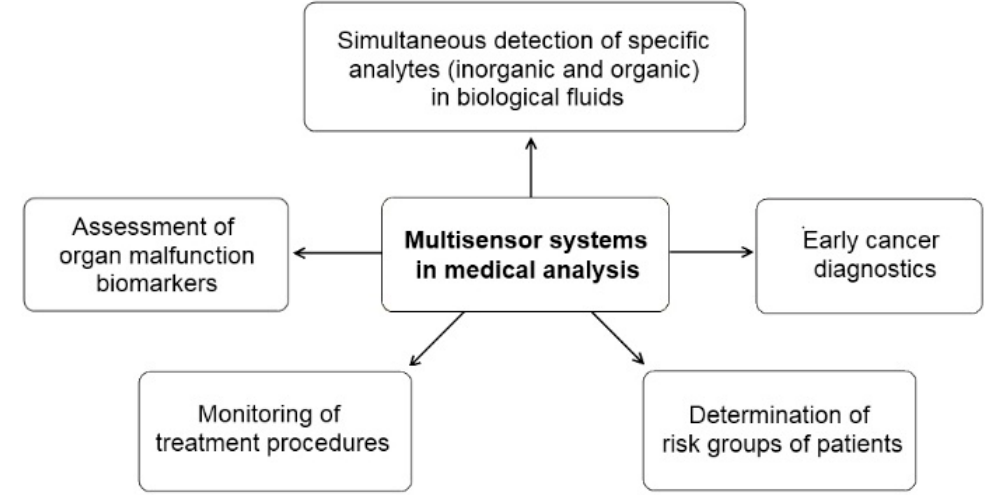
Figure 6. Application of multisensor systems in medical analysis.